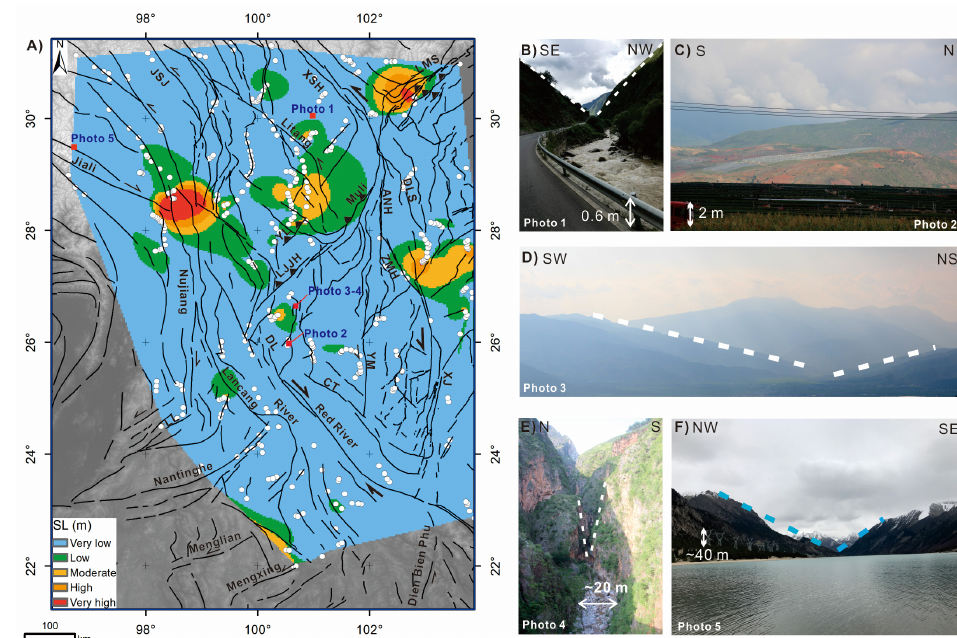
Figure 3. ( A ) Interpolation of stream length gradient (SL) values and the locations of SL points indicated by the white dots. The colors represent the following values: Blue—very low (<1000 m), green—low (1000–2000 m), yellow—moderate (2000–4000 m), orange—high (4000–8000 m), and red—very high (>8000 m). ( B ) shows a V-shaped incised valley with moderate SL values. ( C ) shows low-relief topography with very low SL values. ( D ) shows low-relief topography with moderate SL values. ( E ) shows a deep valley on the surface rupture of the 1515 AD M 7.8 Yongsheng earthquake. ( F ) shows a gentle incised valley with very low SL values. See the locations of the photos in ( A ).